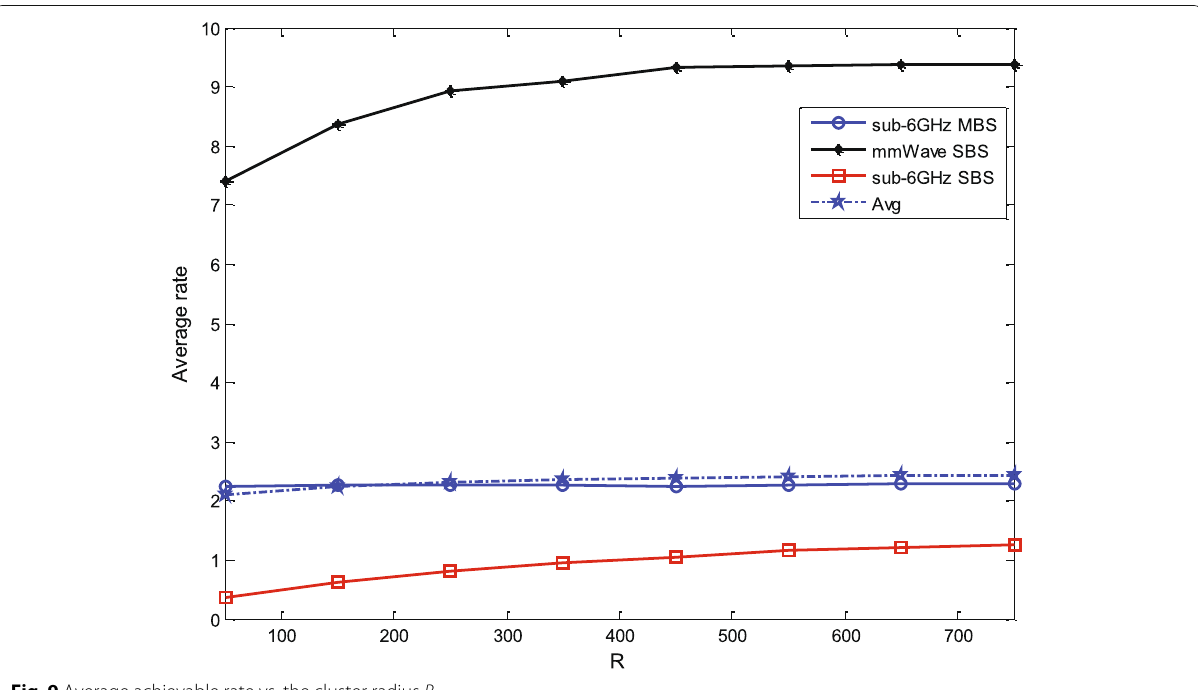
Fig. 9 Average achievable rate vs. the cluster radius R benchmark. The observation in Fig. 12 is that TS algo- rithm is always approximate to the GP for c = 1. Although the gap between GP and BP becomes obvi- ous with the larger c , BP is near to the optimal results under low SINR. The results demonstrate near-optimality